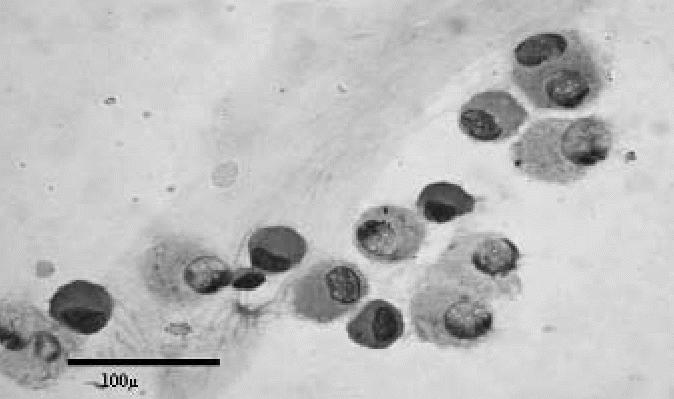
Cytology of BAL sample from an exposed subject showing a predominance of small and medium-sized macrophages (May-Grunwald-Giemsa). Bar = 100 μm.